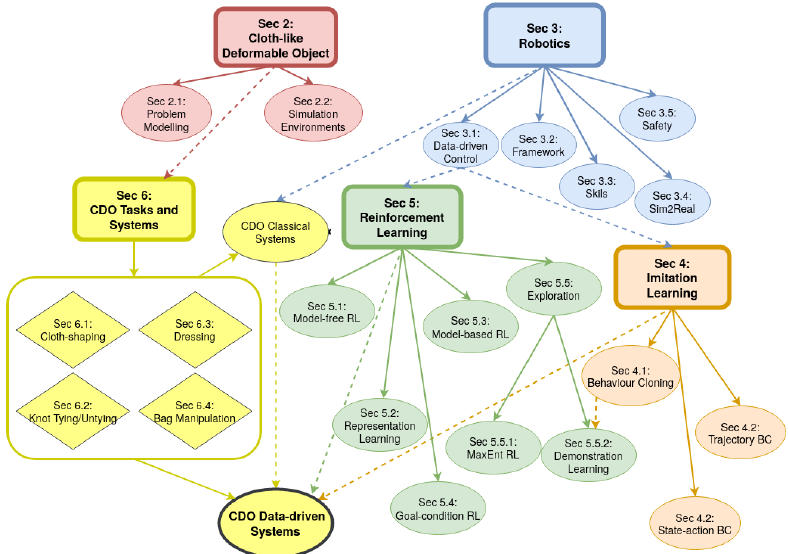
Figure 1. Relationships between different chapters in this review: colours represent individual chapters; solid arrows indicate subsections while dashed arrows show the connection between related